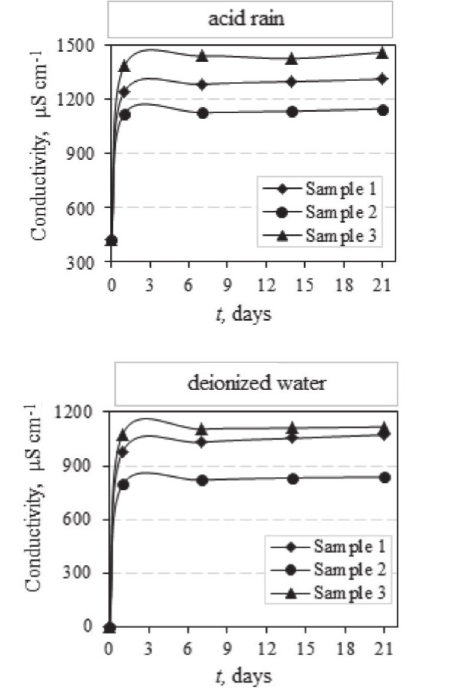
Fig. 2 – Electrical conductivity (EC) of leachates in deion- ized water and synthetic acid